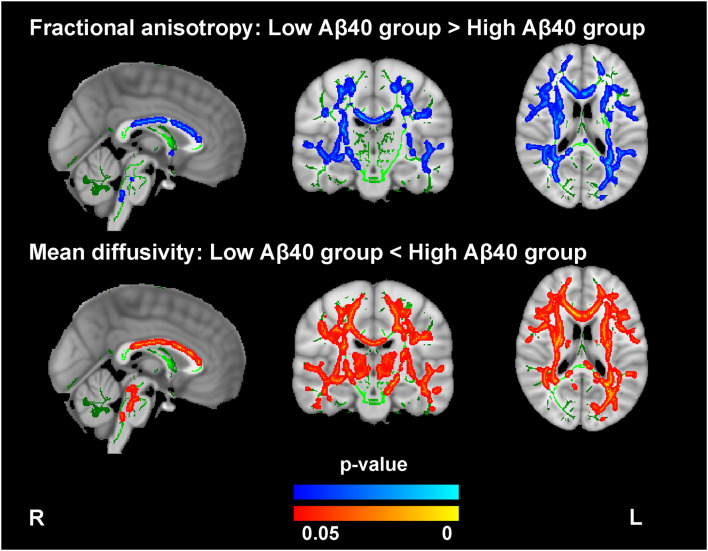
Comparison of the fractional anisotropy (FA) and mean diffusivity (MD) findings between the high and low Aβ40 groups. The averaged skeleton (green color) was overlaid with significantly lower FA (blue-light color) and higher MD (red-yellow color) in the high Aβ40 group compared with the low Aβ40 group (TFCE and FWE corrected p < 0.05, voxels > 100). The analysis controlled for age, sex, and years of education.